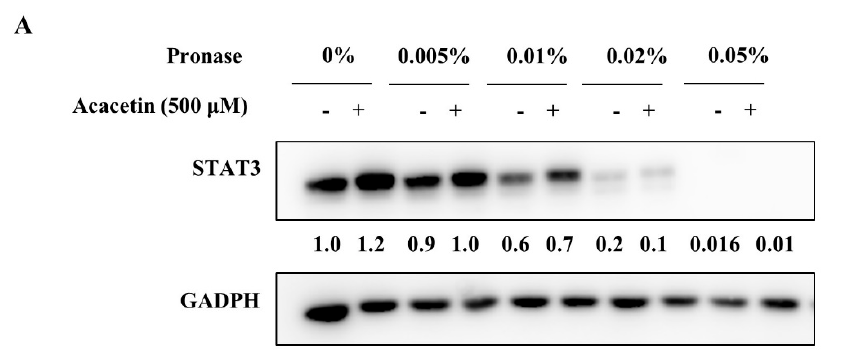
Figure 5. Acacetin binds to STAT3 and inhibits STAT3 activity. ( A ) Structure of apigenin and biotinyl–apigenin. ( B ) Bioti- nyl–apigenin induced the dephosphorylation of STAT3 in DU145 cells. DU145 cells were treated with the indicated con- centration of biotinyl–apigenin for 6 h. Whole-cell lysates were analyzed using Western blotting. ( C ) DU145 lysates were incubated with DMSO or biotinyl–apigenin and then competed with acacetin at the indicated concentration. Binding pro- tein was captured by NeutrAvidin agarose resin and eluted by boiling in SDS-PAGE sample buffer. The eluted protein was analyzed using Western blotting. ( D ) Structural model for acacetin in complex with STAT3. Acacetin is colored yel- low, and hydrogen bonds between acacetin and STAT3 are shown as green dotted lines, and a cation– π interaction is shown as a red dotted